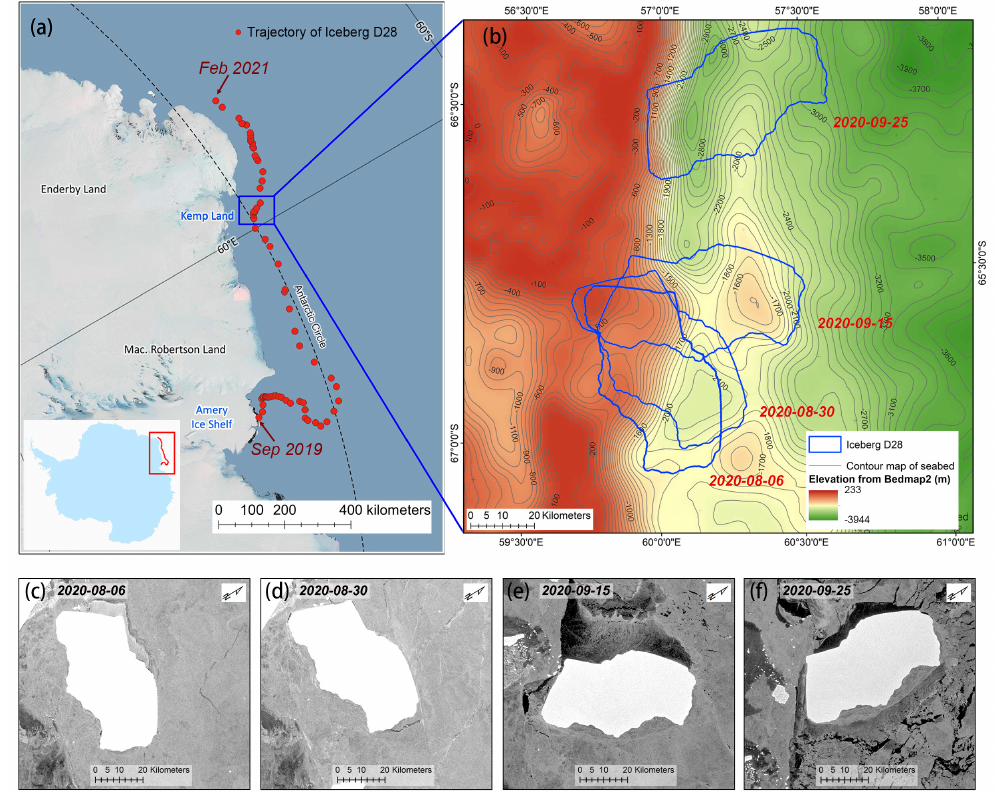
Figure 1. Drifting and grounding of iceberg D28. ( a ) Trajectory from September 2019 to Febru- ary 2021. ( b ) Motion of the iceberg in the grounding area with contour map of seabed elevation from Bedmap2. The iceberg boundaries are delineated from Sentinel-1 SAR images obtained on ( c ) 6 August, ( d ) 30 August, ( e ) 15 September, and ( f ) 25